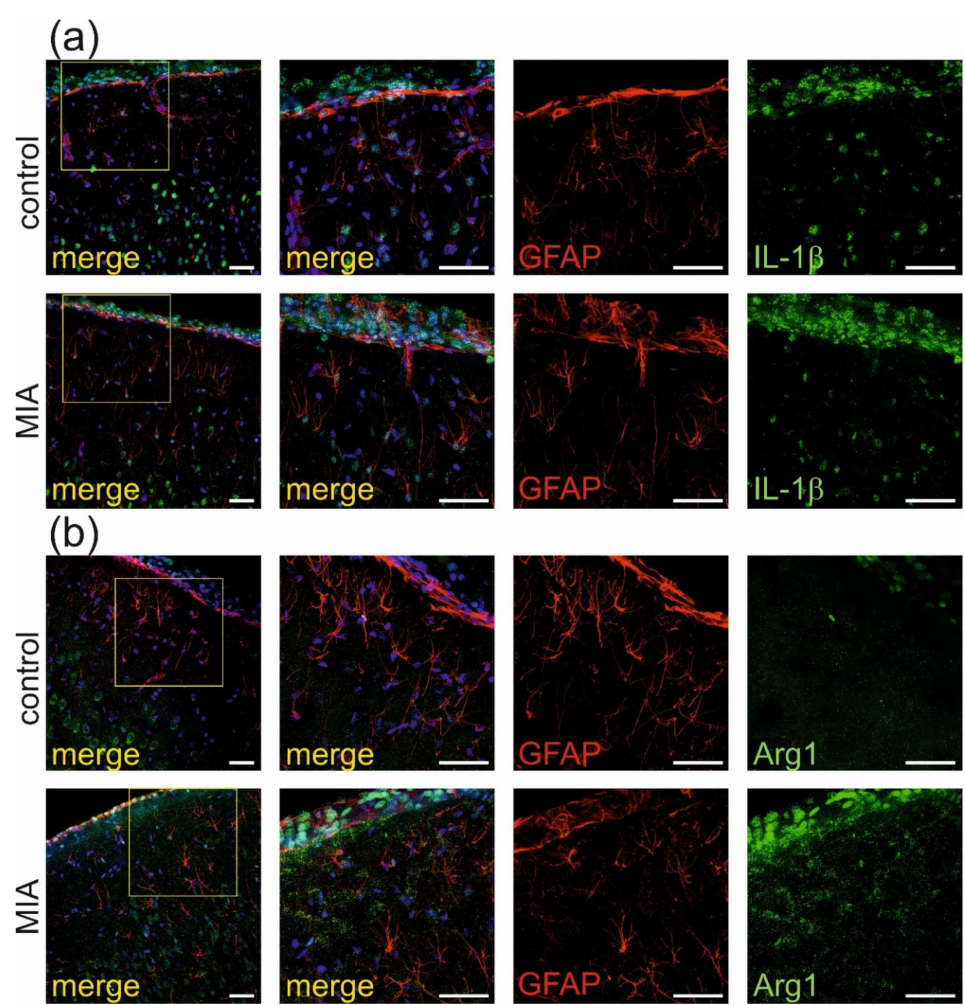
Figure 7. MIA has no e ff ect on activation of astrocytes in brain cortex of adolescent male rats. Immuno-histochemical analysis of somatosensory cortex illustrating astrocytes (GFAP- red) in control and MIA-exposed groups. Co-expression of activation markers, ( a ) IL-1 β (green) and ( b ) arginase-1 (green), with GFAP-positive cells has not been observed. The nuclei were counterstained with DAPI (blue). Scale bar = 50 µ